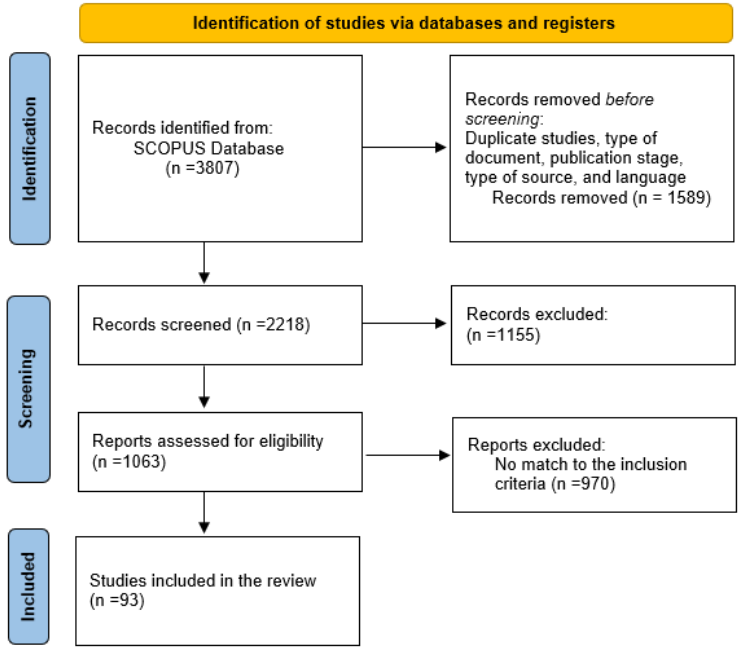
Figure 2. PRISMA flow diagram for study